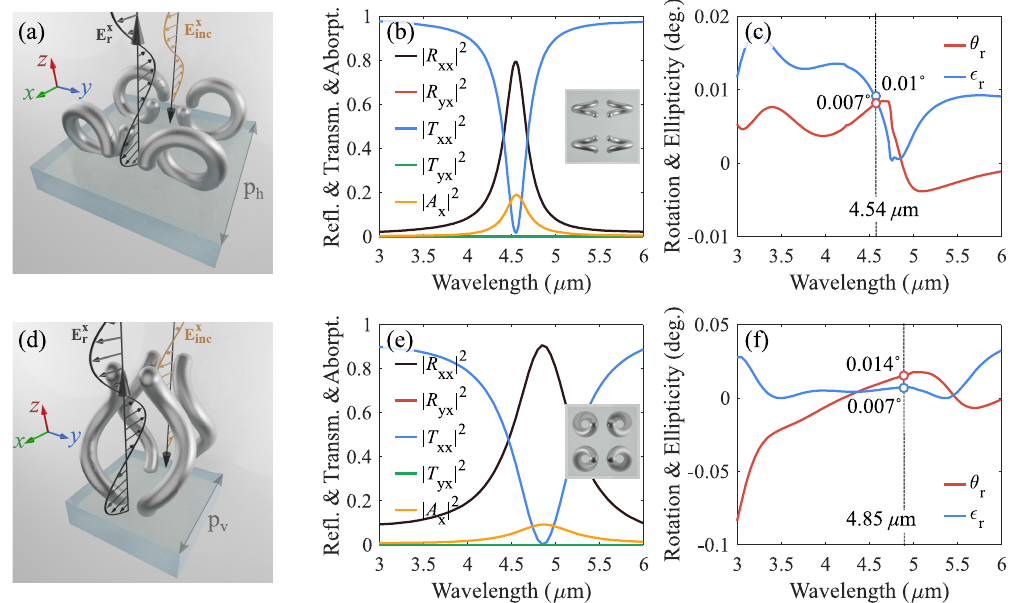
Figure 4. ( a ) The unit cell of a metasurface designed for the copolarized reflection regime. The unit cell consists of horizontally-oriented helices with the lattice period of p h = 1.8 µ m. ( b ) Simulated reflectance, transmittance, and absorbance spectra with corresponding polarization states. The top view of the unit cell is depicted in the inset. ( c ) The rotation θ r and ellipticity (cid:101) t wavelength dependence of the corresponding metasurface. ( d ) The unit cell of a metasurface consists of vertically oriented helices with a lattice period of p v = 1.2 µ m for copolarized reflectance. ( e ) Co- and cross-polarized reflectance, transmittance, and absorbance spectra with the top view of the unit cell in the inset. ( f ) The rotation and ellipticity wavelength dependence of the vertically oriented helix-based